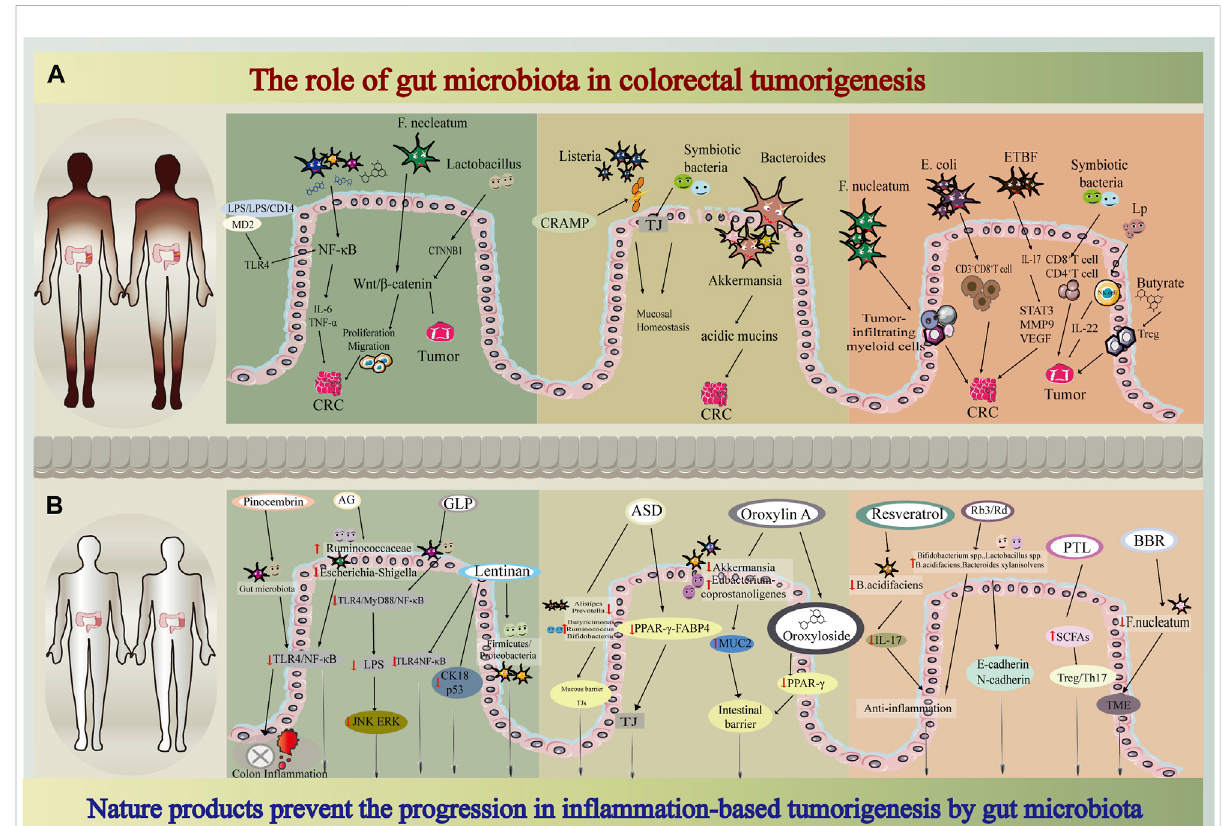
FIGURE 1 Flow diagram of mechanistic study through nature products, gut microbiota, colorectal tumorigenesis (A) The role of gut microbiota in colorectal tumorigenesis (B) Nature products prevent the progression in in fl ammation-based tumorigenesis by gut